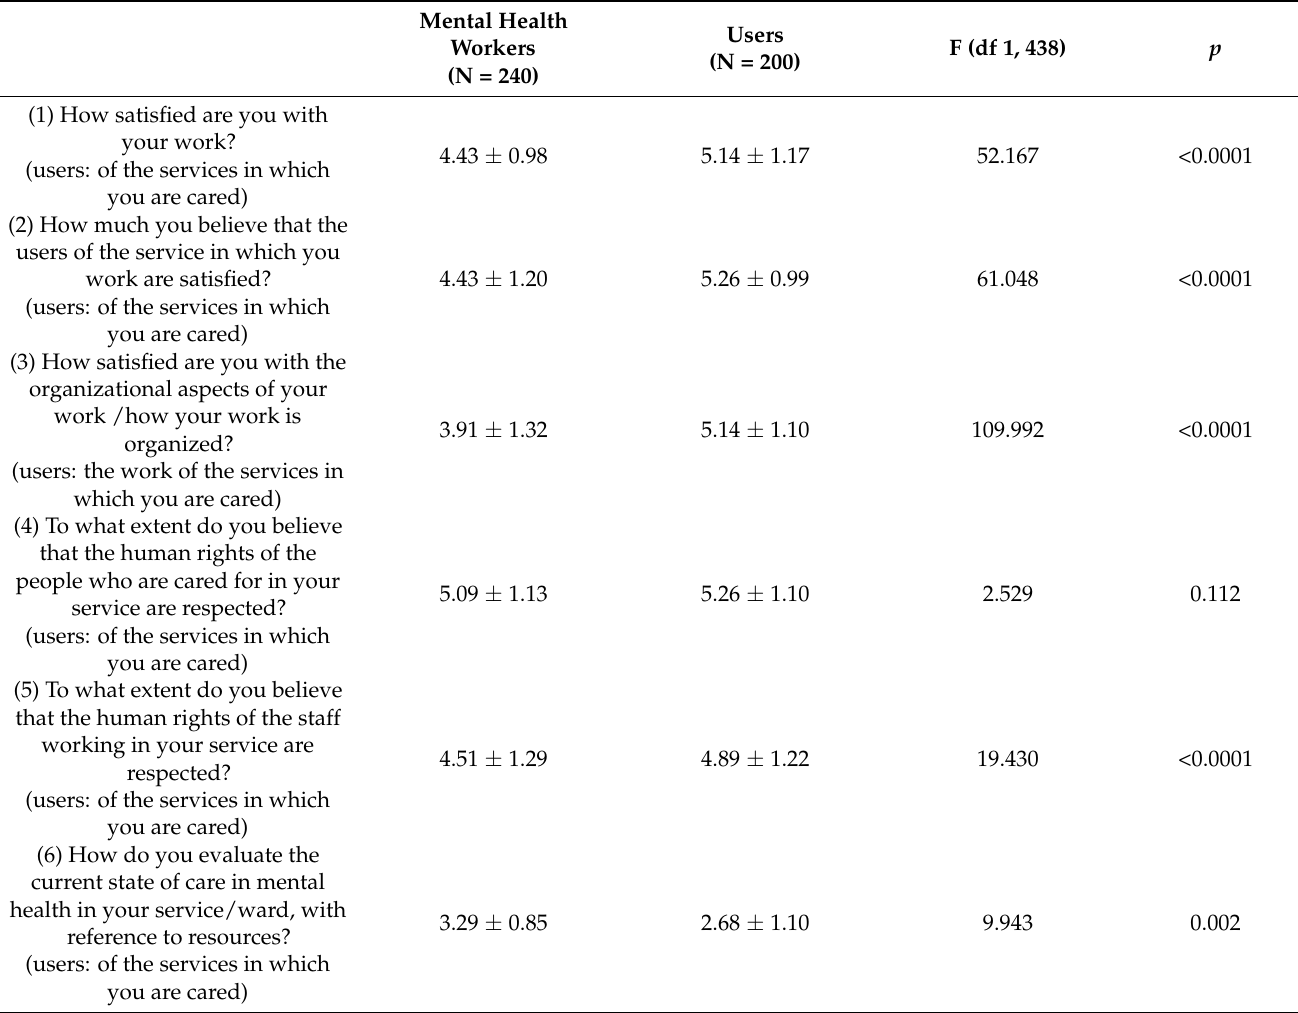
Table 2. Comparison on answers at item 1-6 of WWRR about health workers and users of mental health services of South